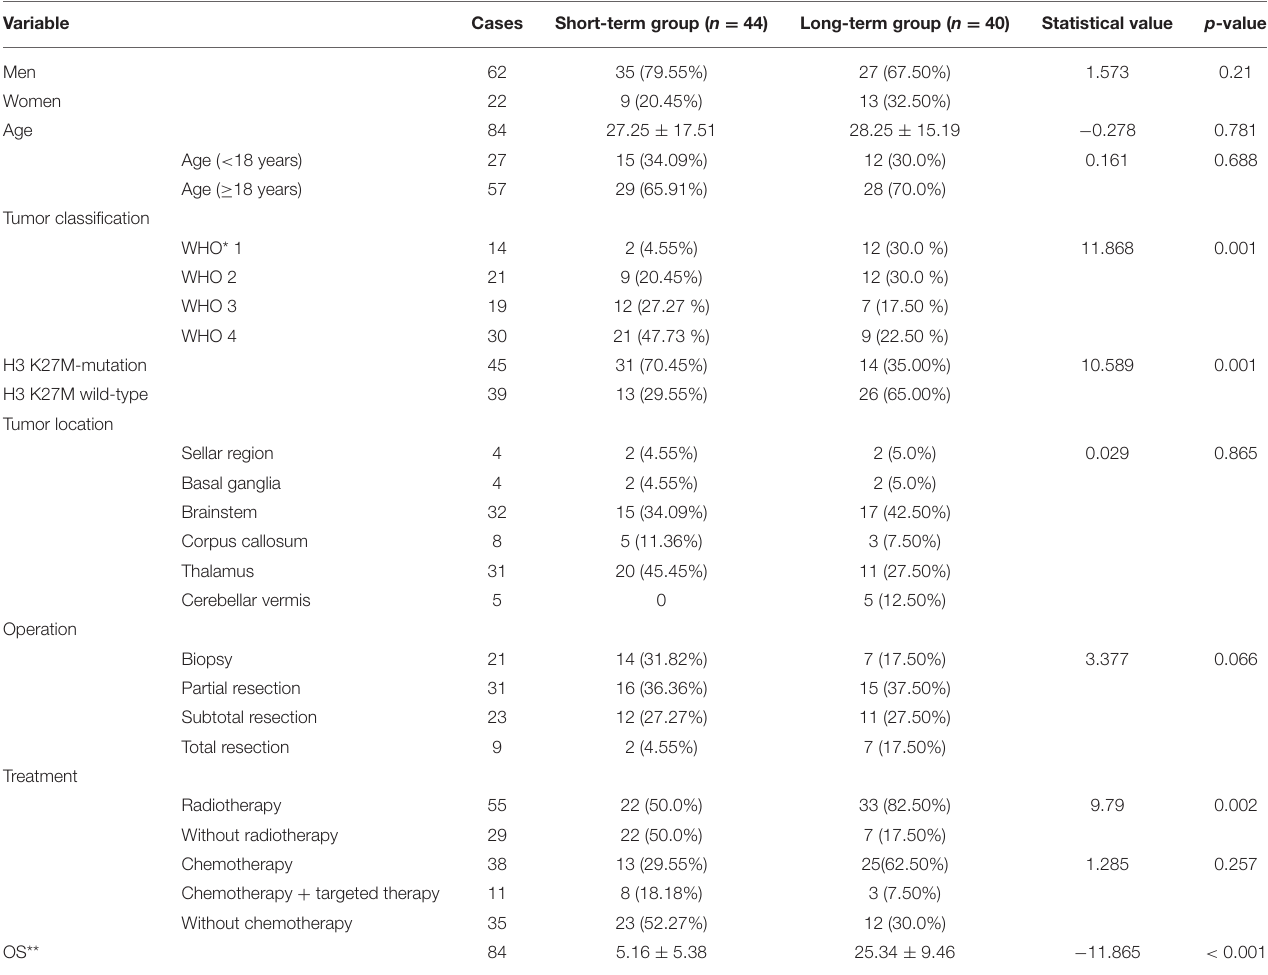
TABLE 1 | Clinical characteristics of 84 patients in the short-term and long-term groups.